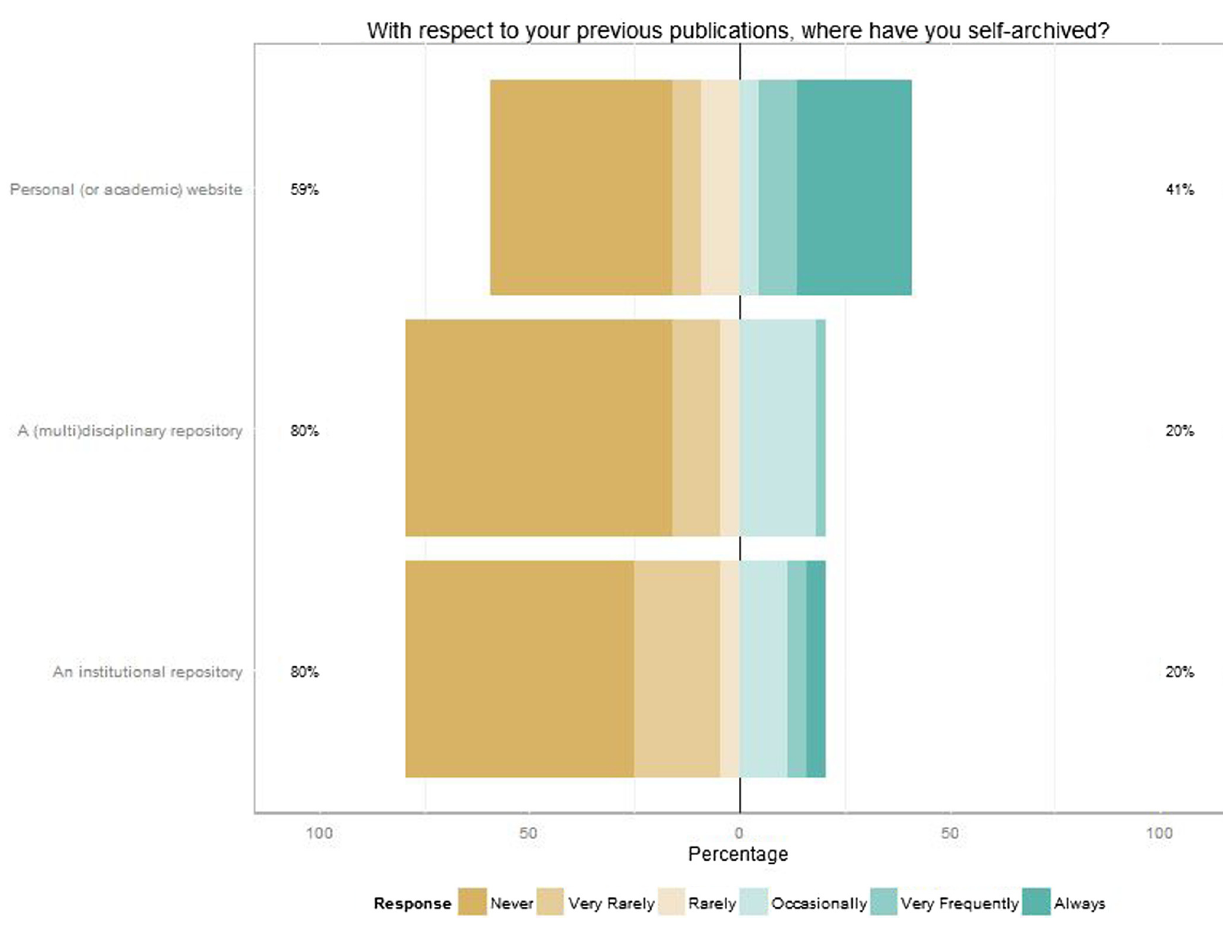
Figure 5. Answers to the question: With respect to your previous publications, where have you self-archived?